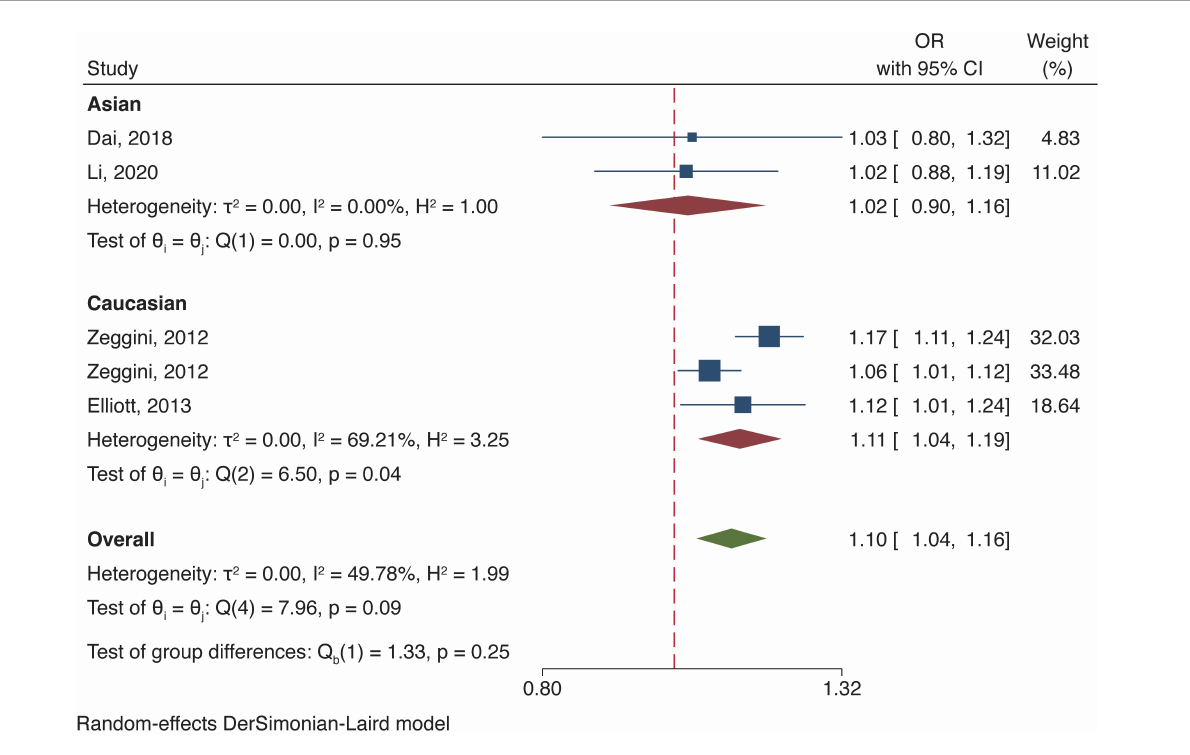
FIGURE4 Meta-analysis of FTO gene polymorphism and OA risk in female